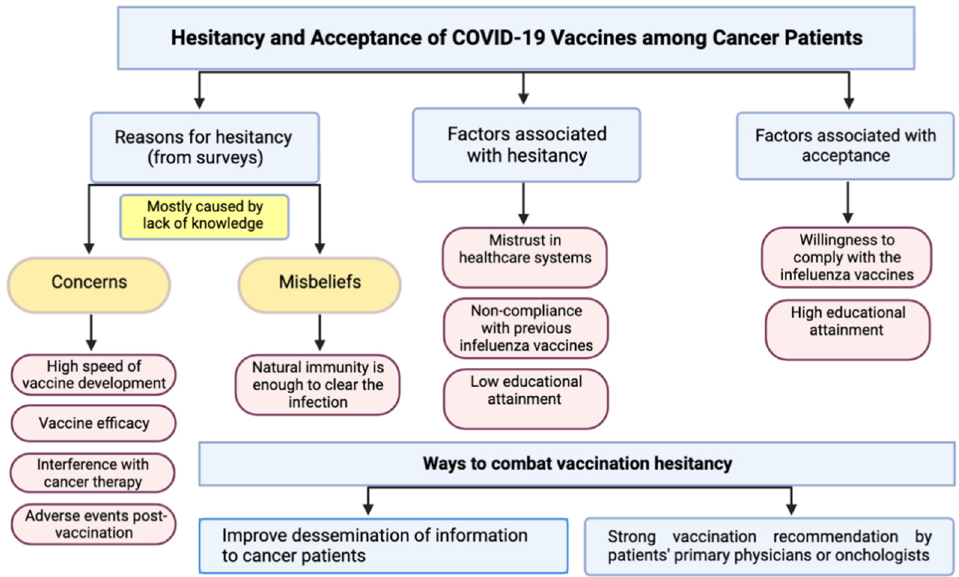
Figure 2. Reasons for and factors associated with vaccination hesitancy or acceptance among cancer patients compiled from studies which conducted surveys in different countries and the suggested ways to combat such hesitancy.